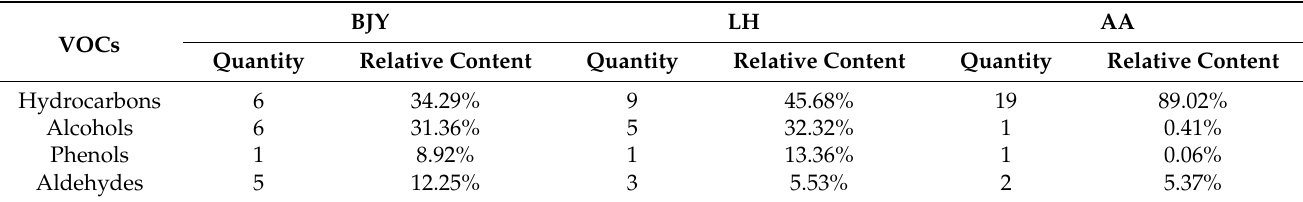
Table 6. Comparison of the VOCs of different types of chicken breast.